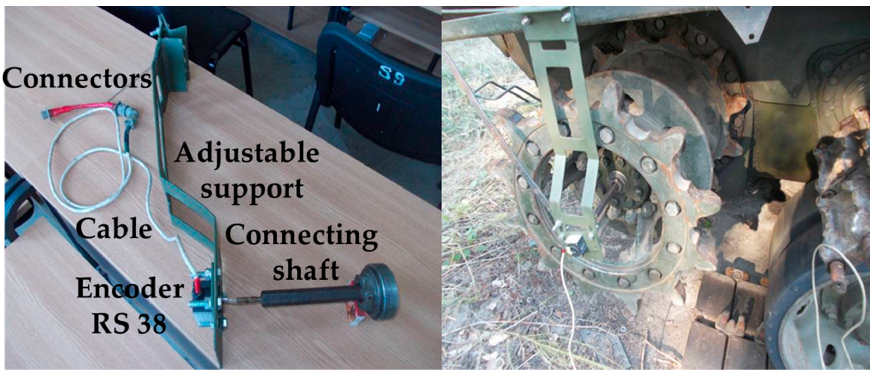
Figure 14. Mounting the RS-38 optical encoder on the right-hand drive wheel.